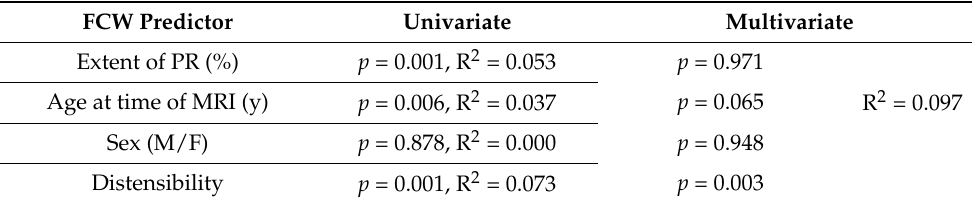
Figure 2. ToF − repaired patients exhibited significant differences in FCW peaks between patients with no PR and those with any severity of PR. This change was also seen in the wave energy (taken from the FCW area). Table 3. Summary of the regression analysis for predictors of the forward compression wave (FCW). PR = pulmonary regurgitation, MRI = magnetic resonance imaging.